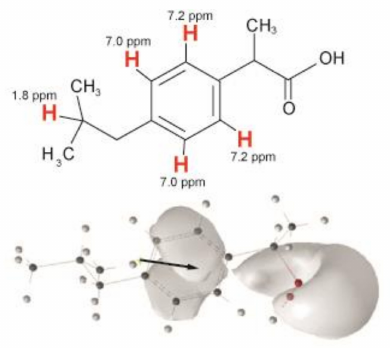
Figure 1. Chemical structure of ibuprofen ( top ) with the assignment of the resolved proton signals (red) and orientation of the dipole moment (black arrow) and isosurface of the electrostatic potential ( bottom